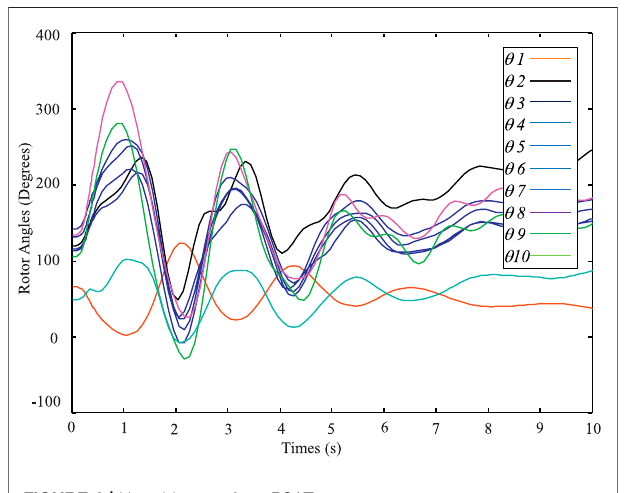
FIGURE 6 | Unstable case from PSAT.